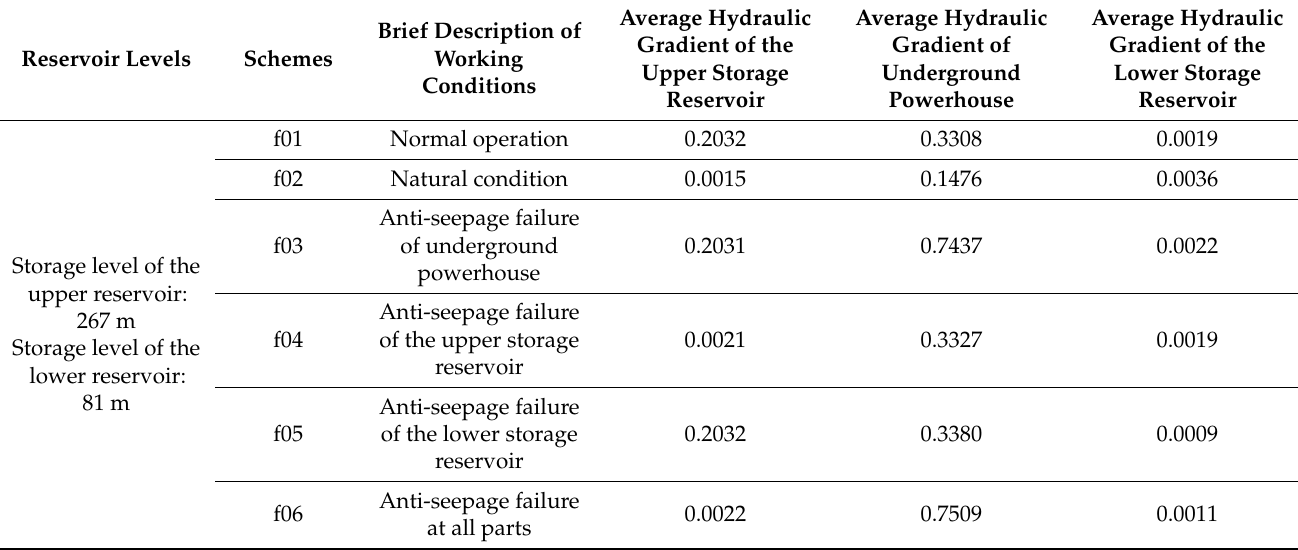
Table 5. Statistical results of hydraulic